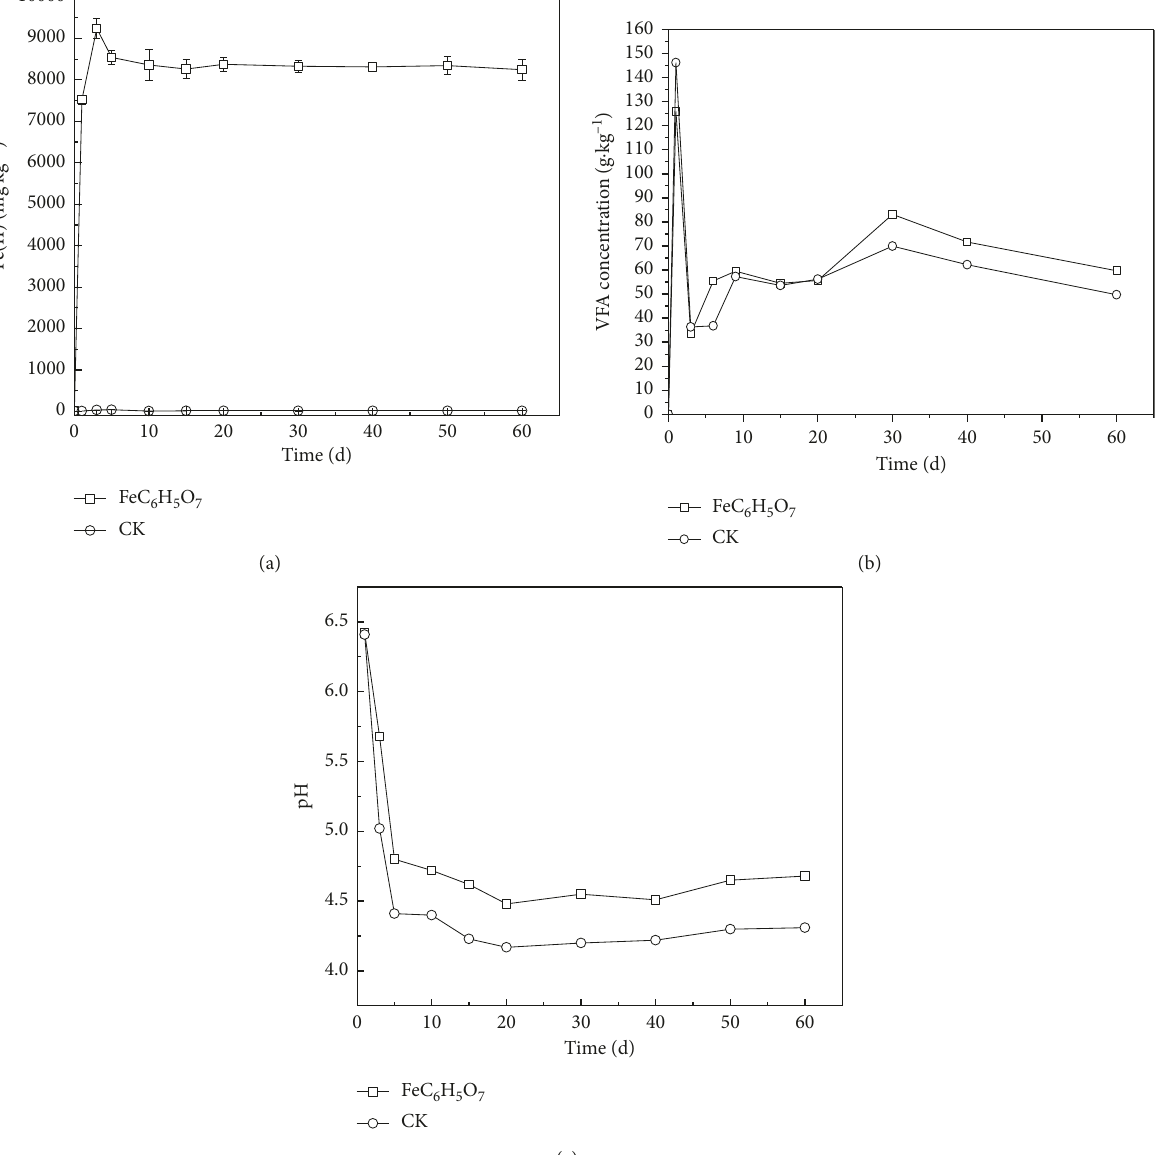
Figure 7: Changes in Fe(II) (a), VFA (b), and pH (c) with time in the destructive testing